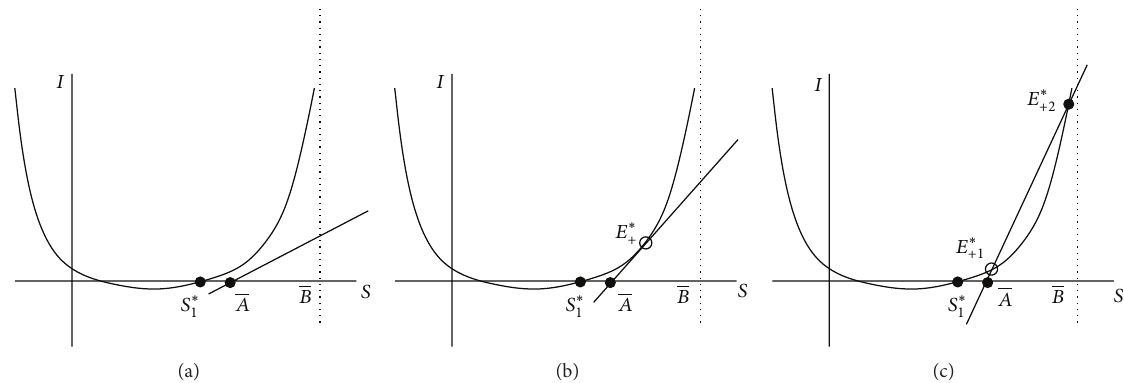
Figure 3: Related to Proposition 6, possible configurations of the nullclines when 𝑆 ∗ 1 < 𝐴 < 𝐵 . (a) 𝑆 ∗ 1 is global attractor. (b) 𝑆 ∗ 1 is an attractor. (c) The bistable case: 𝑆 ∗ 1 and 𝐸 ∗ +2 are locally asymptotically stable while 𝐸 ∗ +1 is a saddle.